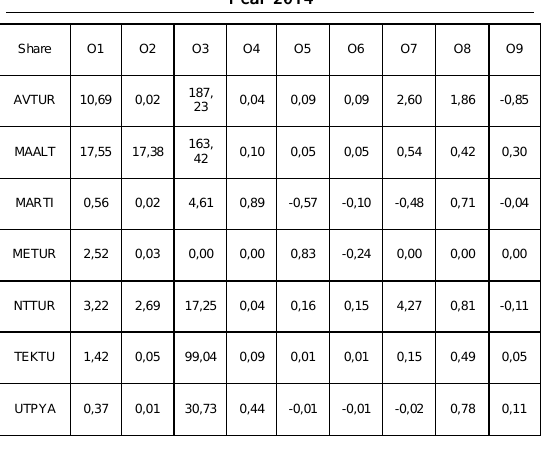
Table 6: Annual Standard Decision Matrix for the 2013- 2016 Period